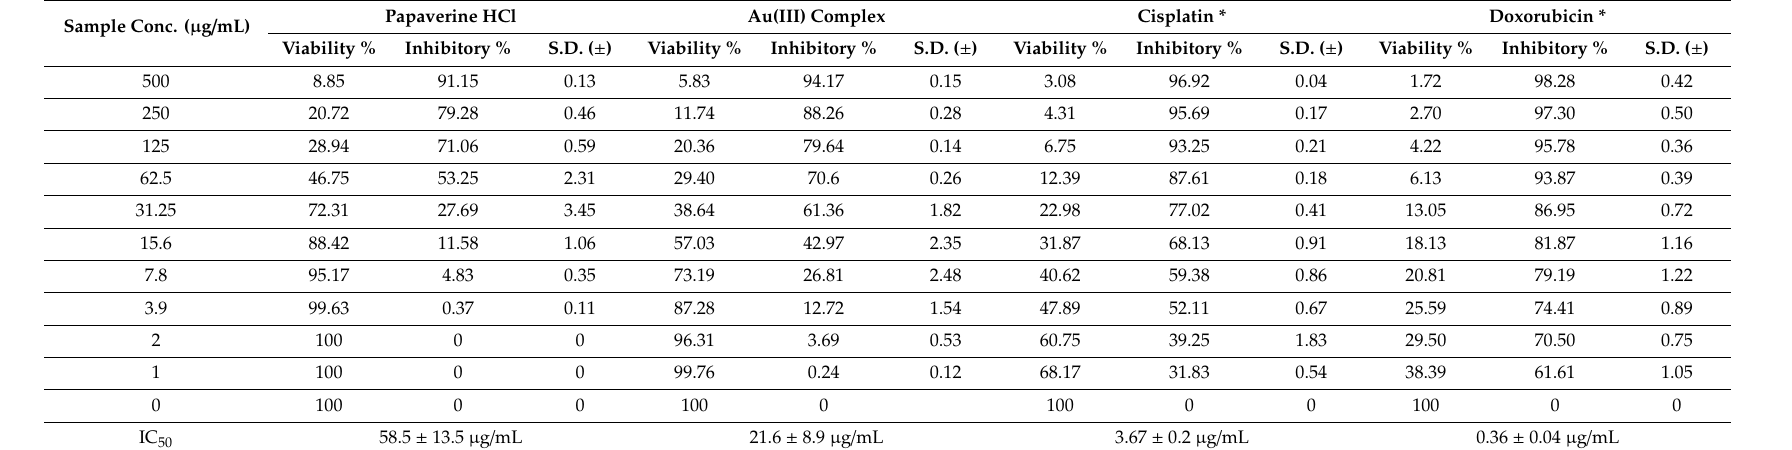
Table 8. The anticancer e ff ects of papaverine HCl and its Au(III) complex in human HepG-2